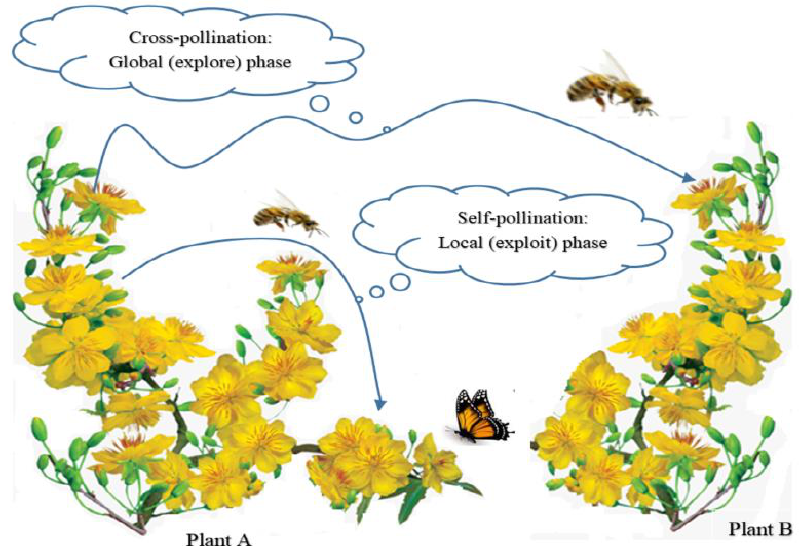
Figure 2. An illustration of types of flower pollination: self-pollination and cross-pollination. ( A ) self-pollination and ( B )